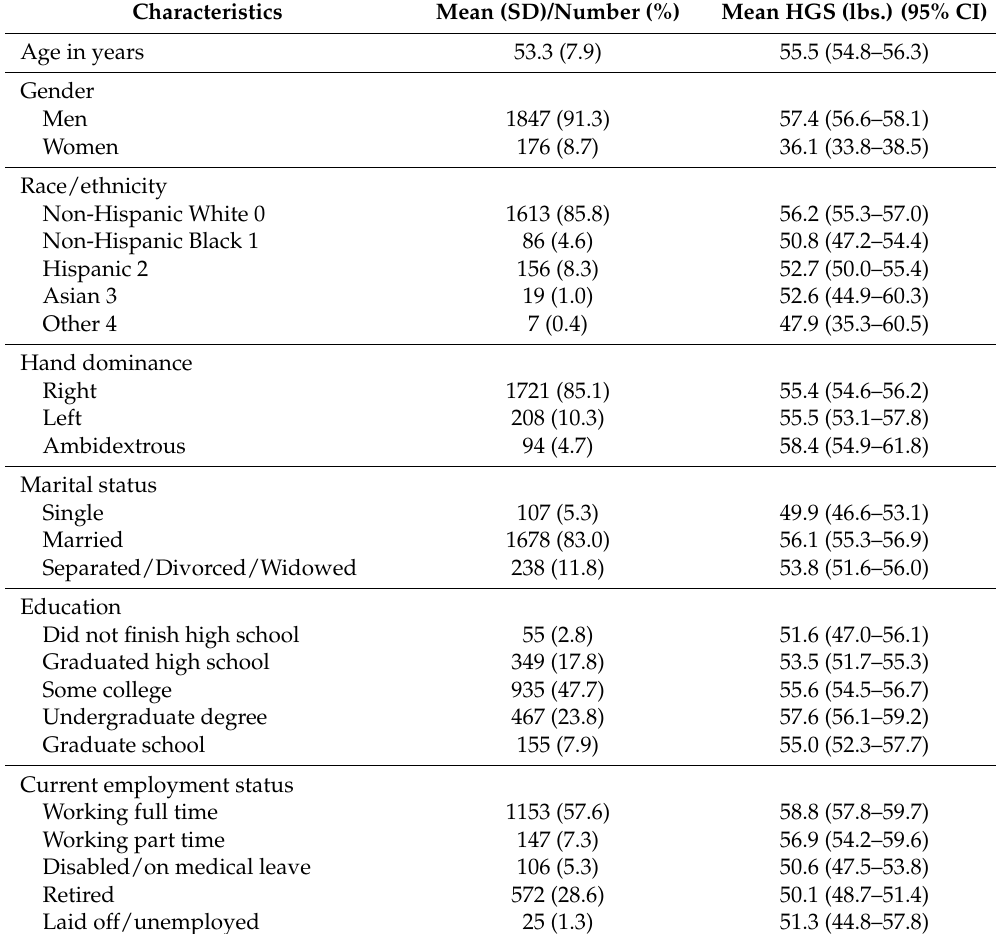
Table 1. Distribution of handgrip strength (HGS) with independent variables among World Trade Center (WTC) responders ( n =